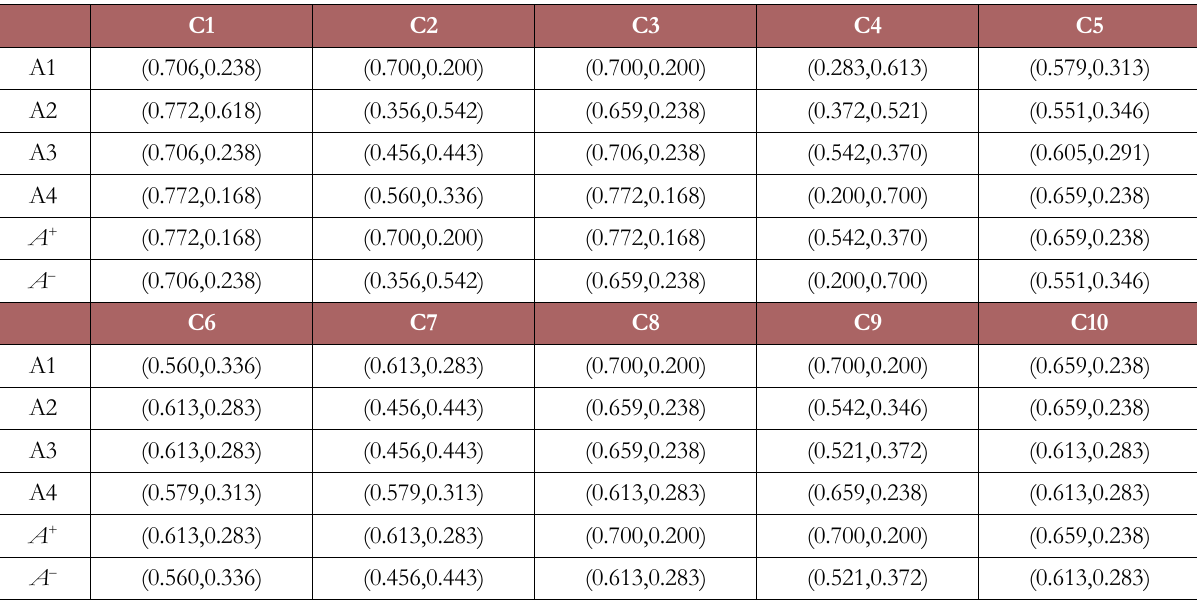
Table 20. Normalized decision matrix, PIS and NIS, in the form of IFNs Aggregrated fuzzy weight in Table 16 was transformed to constant weight vector ( ω ) (by calculating closeness j coefficient of each indicator following Equation (13) – Equation (15) as shown in Table 21. As the sum of weights should be equal to 1, normalization is applied to closeness coefficient to determine the final constant weights.